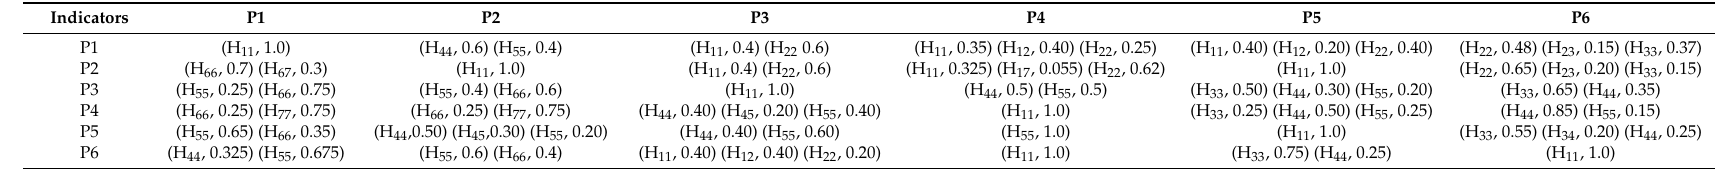
Table 3. Group assessment of the experts on patient related